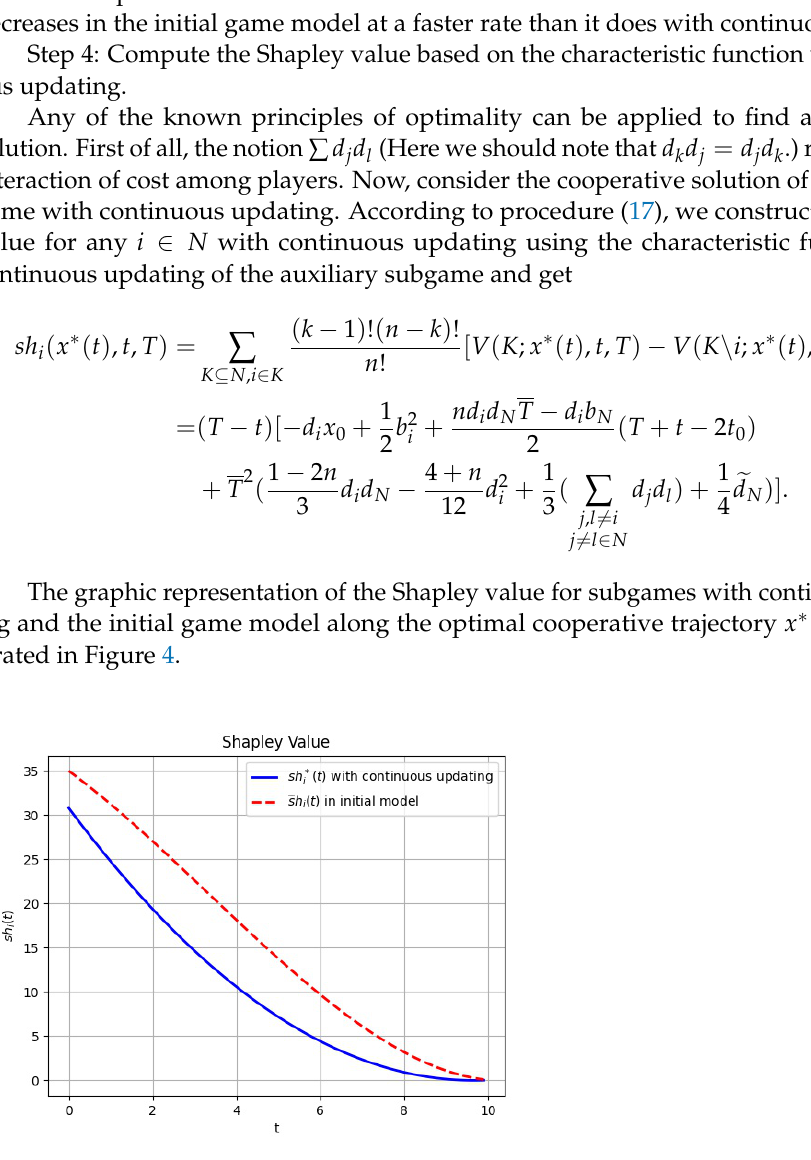
Figure 4. The Shapley value of player i in the initial game (red line) and the Shapley value with ( t ) (blue continuous updating sh ∗ i